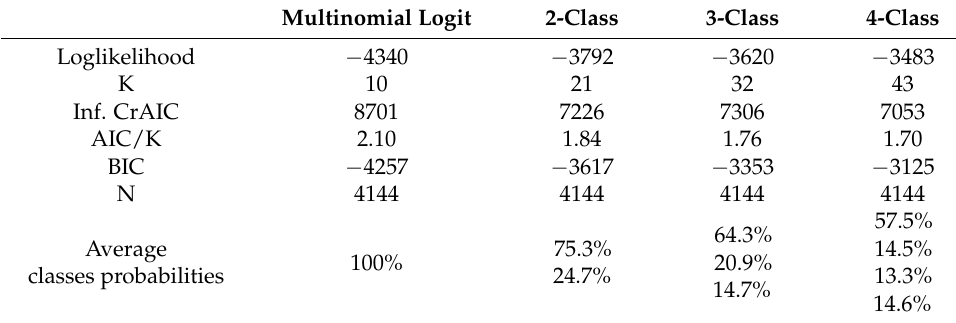
Table 5. The information criteria values for models 1 to 4